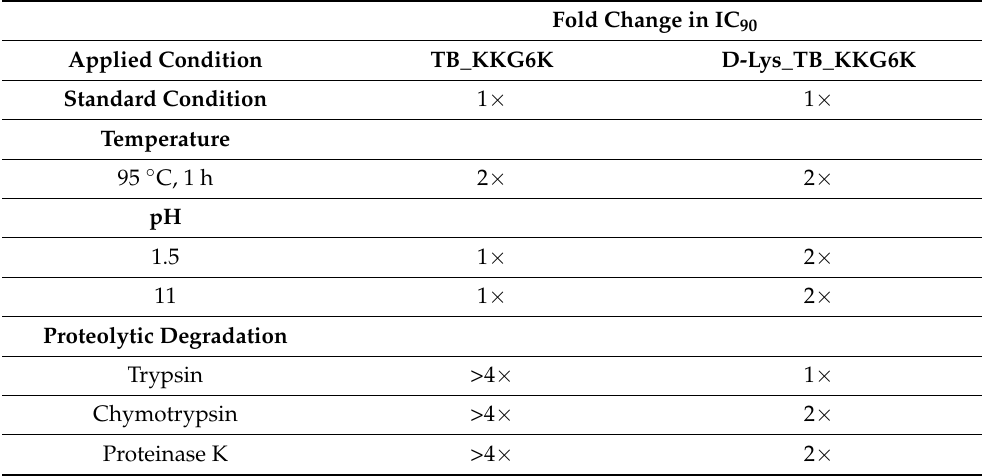
Table 3. Sensitivity of the TB analogs to high temperature, extreme pH and proteolytic degradation § .